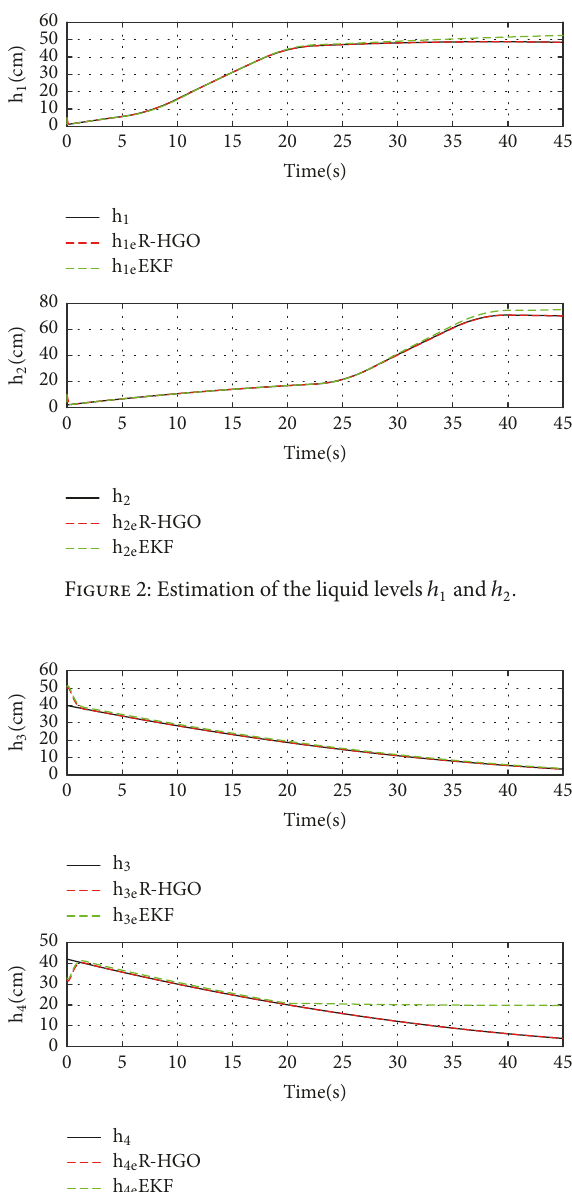
Figure 3: Estimation of the non-measured liquid